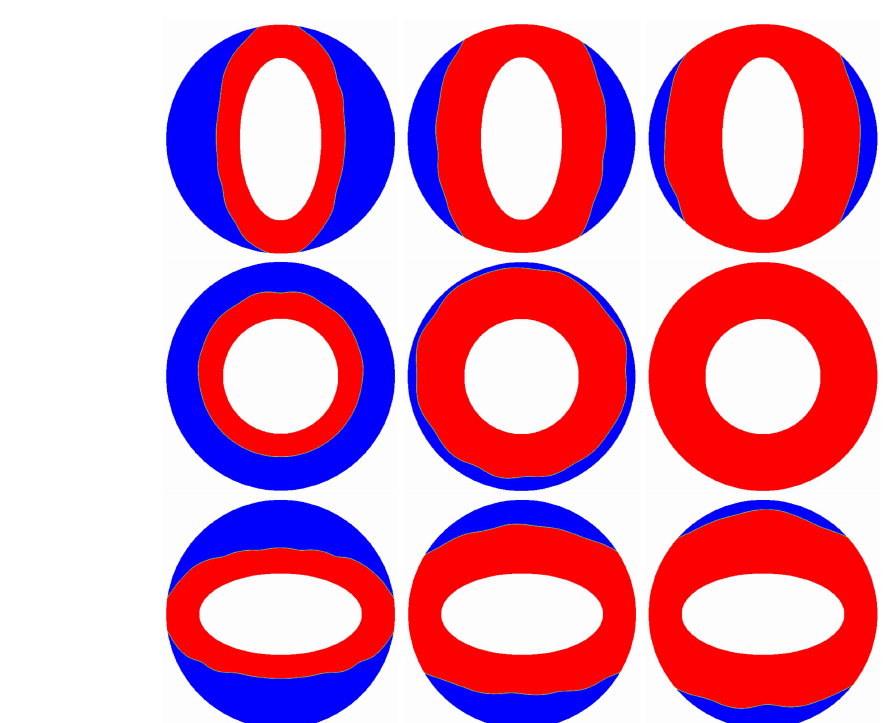
Figure 10. The transient distributions of the solid-liquid interface for different aspect ratios (( a ) AR =